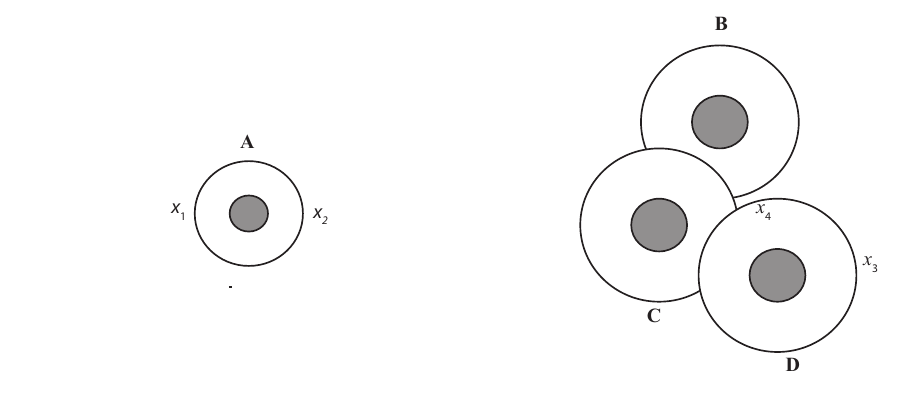
Figure 7: Illustration of the dynamic implications of the theory. disparate information sources: “BI platforms en- able users to build applications that help orga- nizations learn and understand their business” (Richardson et al.